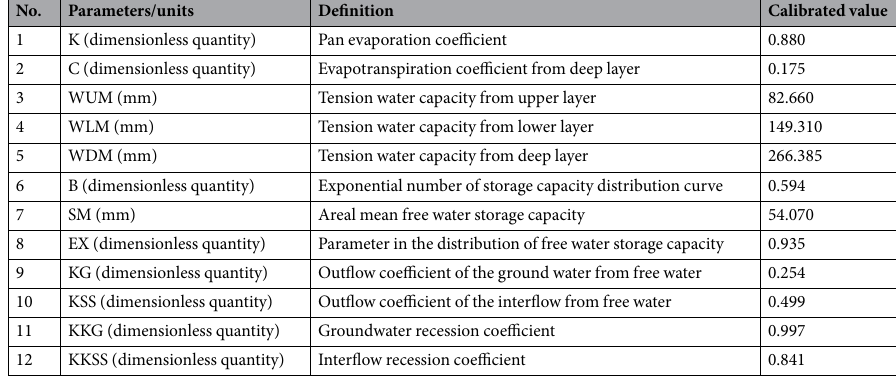
Table 1. Calibrated parameters and calibrated values for the Nanliu river